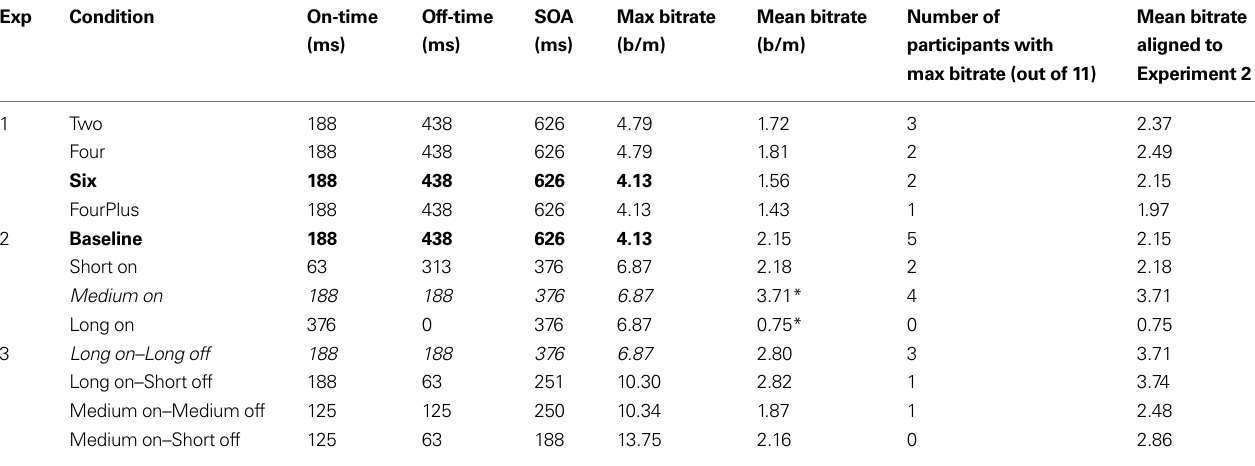
Table 1 | Timing characteristics and bitrate results for the different conditions in the different experiments. The maximal bitrate is the bitrate that would be achieved when classifi cation would always be correct. The mean bitrate is the bitrate achieved in the corresponding condition, averaged across participants. Asterisks indicate a signifi cant difference within an Experiment as indicated by Tukey post-hoc tests. In the next column, the number of participants that achieved the maximal achievable bitrate is indicated. The last column presents the mean bitrate aligned to Experiment 2 (see General Discussion). Equal conditions in different experiments that serve to compare results between experiments are highlighted in bold and italic